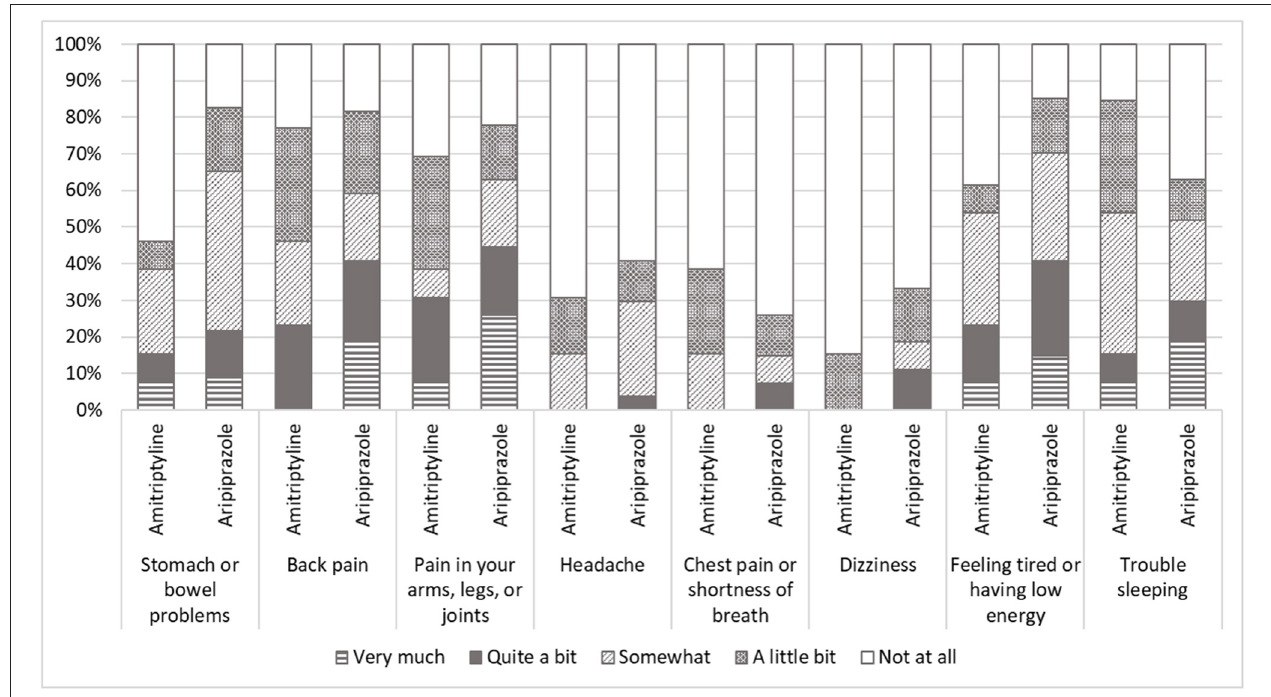
FIGURE 2 | The scores of somatic symptom scale-8 (SSS-8). While most comorbid somatic symptom was “trouble sleeping” in the patients with amitriptyline, “stomach or bowel problems” and “feeling tired or having low energy” were the most in the patients with aripiprazole. “Back pain” and “pain in arms, legs, or joints” were also observed in many patients in both patients with amitriptyline and with